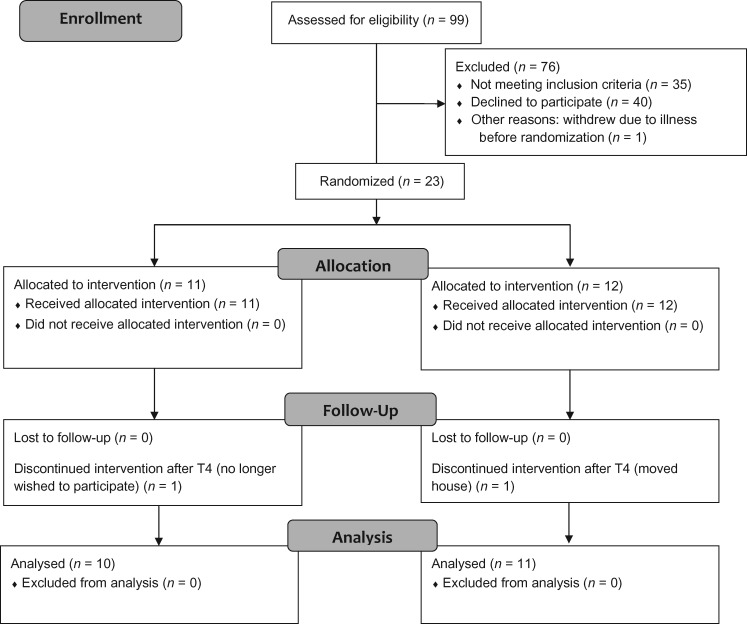
Consolidated Standards of Reporting Trials (CONSORT) flow diagram..